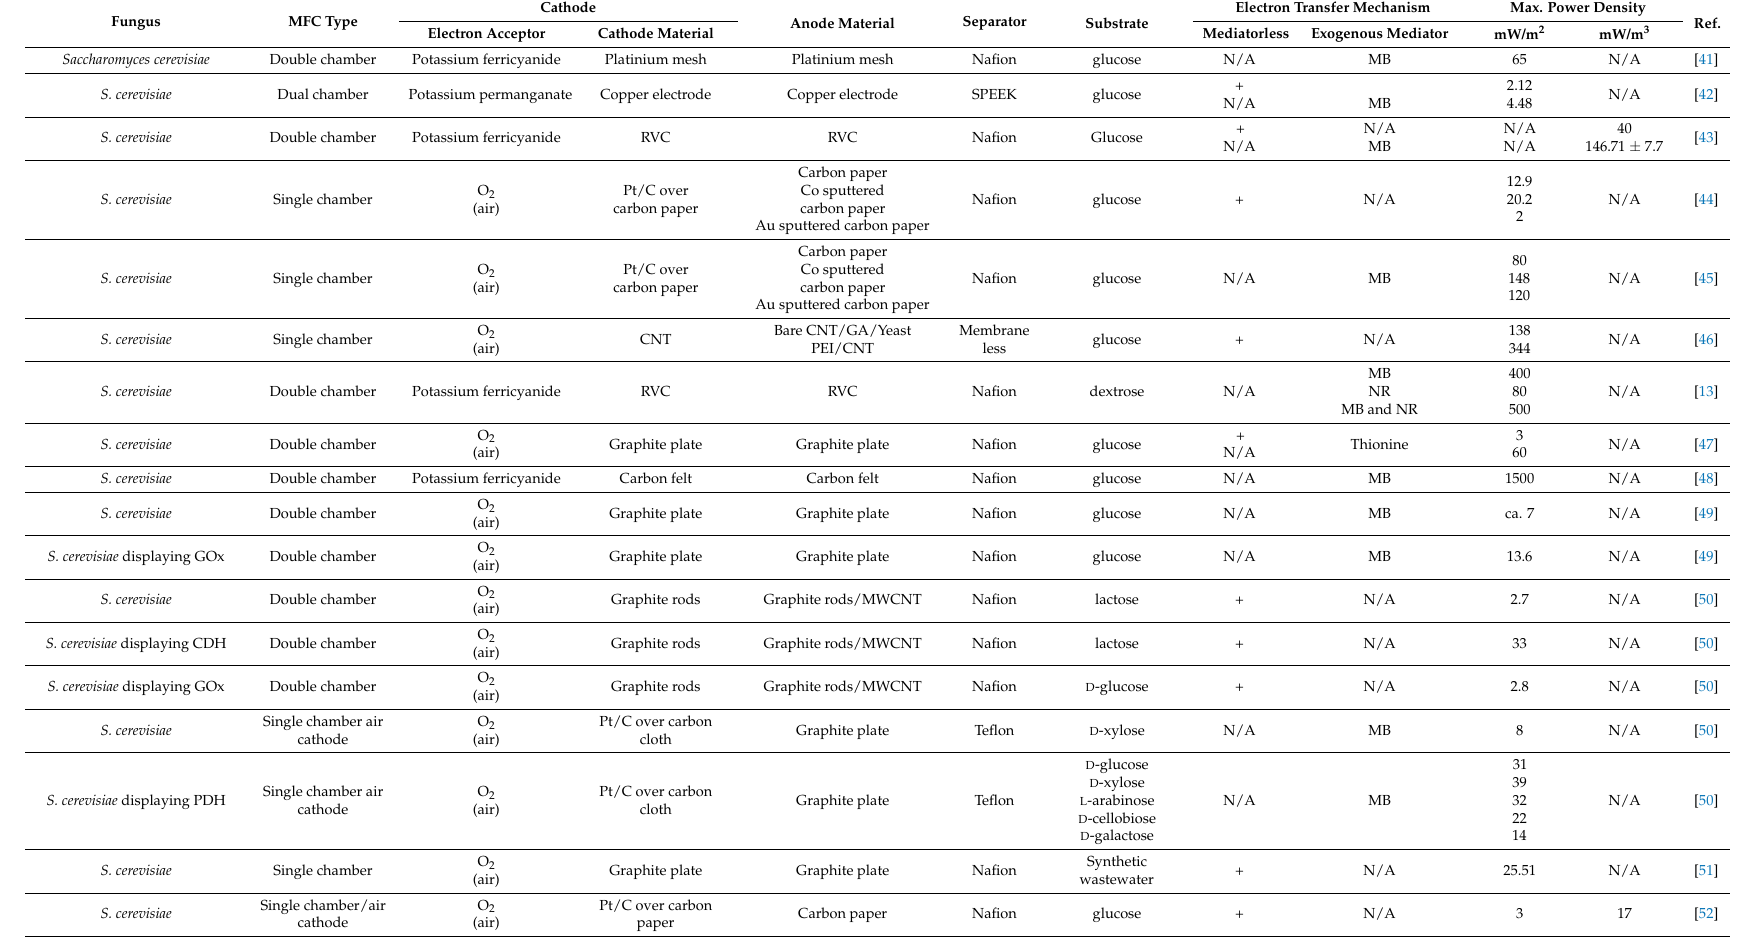
Table 1. MFCs with fungi as anodic